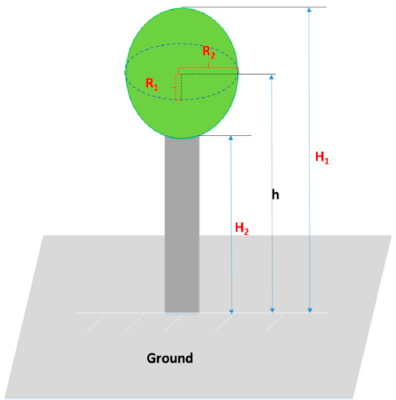
Figure A1. Measured parameters for sample trees selected to build regression relationships for the structural parameters of the tree crown and other measures, including tree height and DBH.